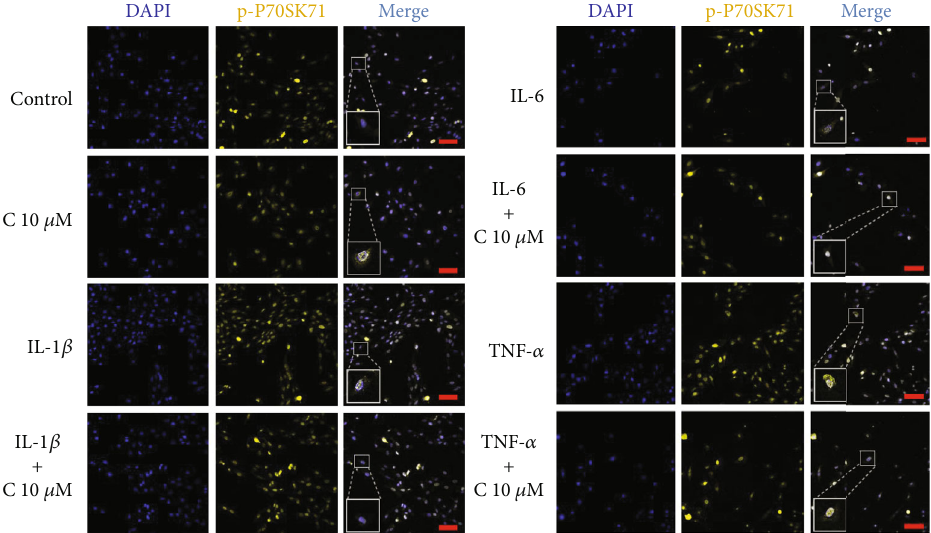
Figure 6: Representative images of subcellular localization of the p-P70SK61 protein in SW982 cells after 24h incubation with curcumin (10 μ M) and cytokines (50 ng/ml). The photographs were taken on a Zeiss Cell Observer SD confocal microscope. Scale bar = 100 μ